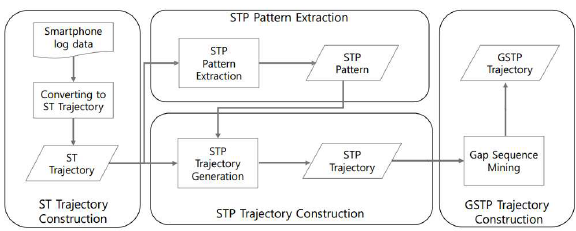
Fig. 11 Extracting process of spatiotemporal pattern and predictor training process [57]